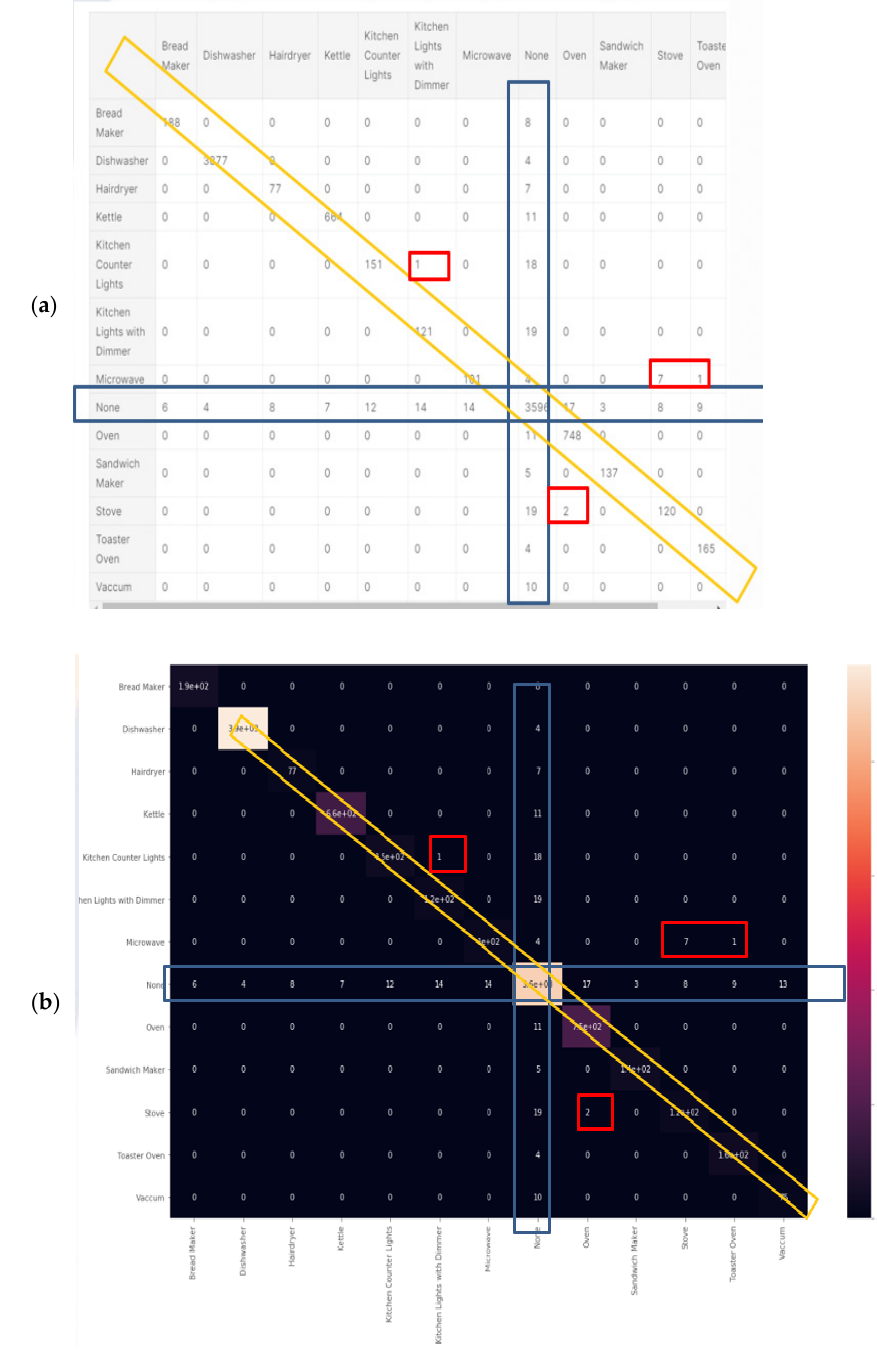
Figure 17. Decision tree ( a ) confusion matrix and ( b ) Pearson’s correlation heatmap.